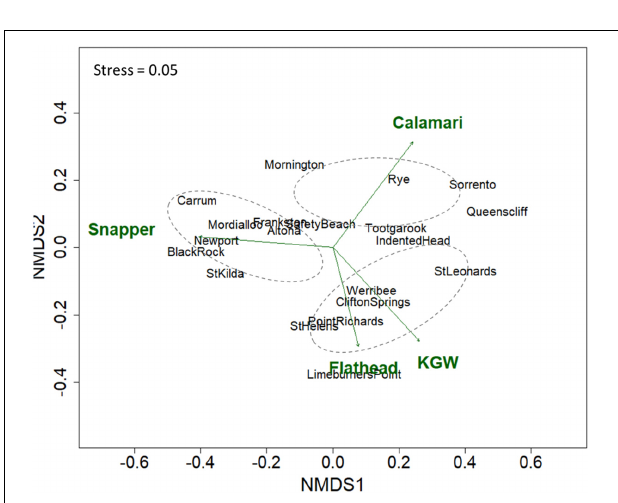
FIGURE 4 | Ordinations of nMDS analyses illustrating patterns of four main target species across boat ramps based on the survey data combined across years. Ellipses represent 95% confidence intervals further indicating the clusters of boat ramps deriving patterns in target